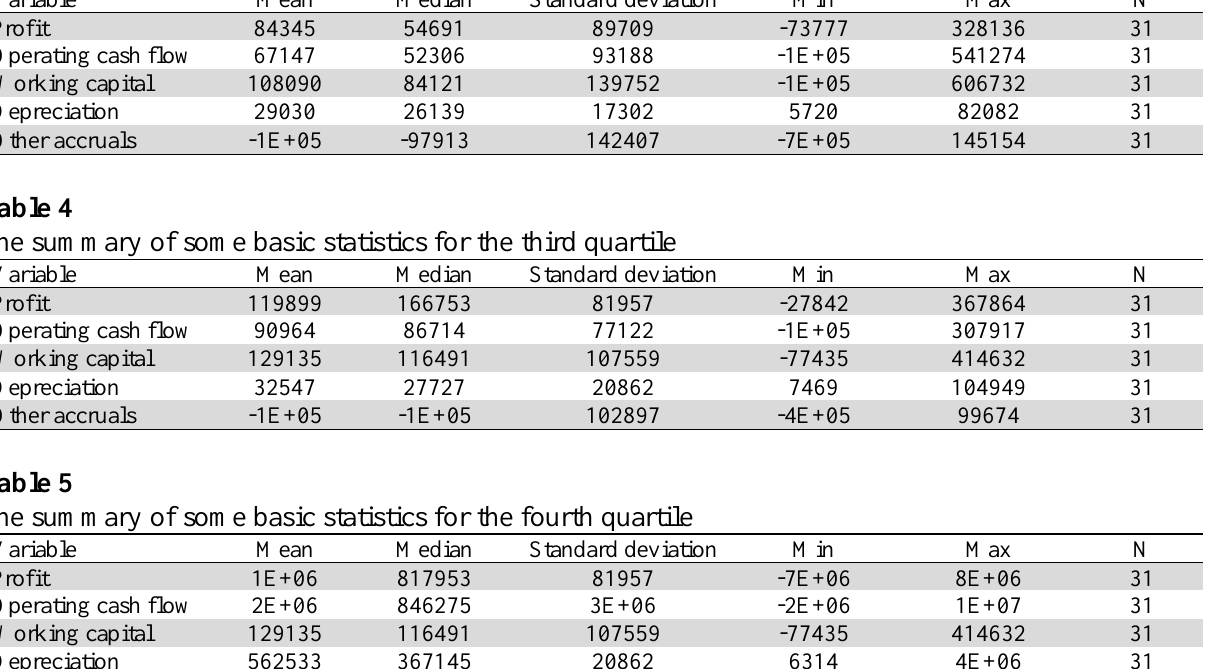
The summary of some basic statistics for the second quartile Variable